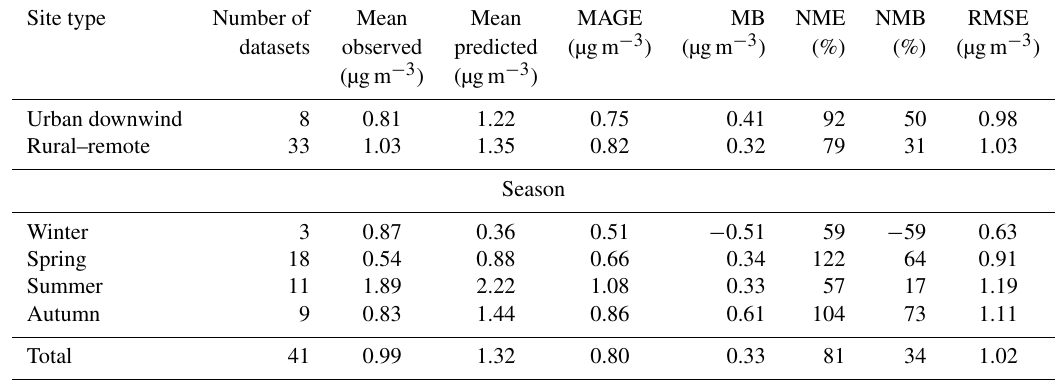
Table 4. Statistical evaluation of EMAC fresh SOA against AMS SVOOA from 41 datasets worldwide during 2001–2010. Site